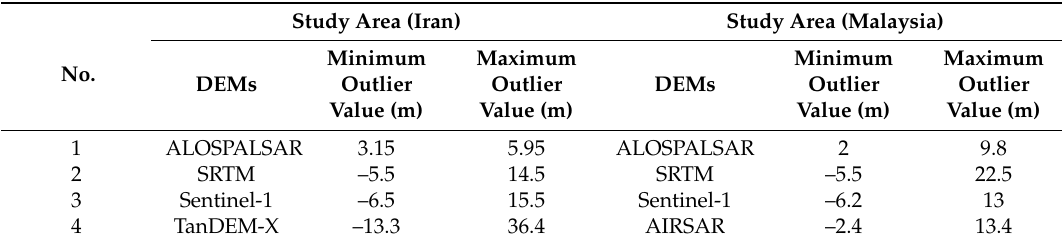
Table 3. Minimum and maximum outlier values for the both study areas.